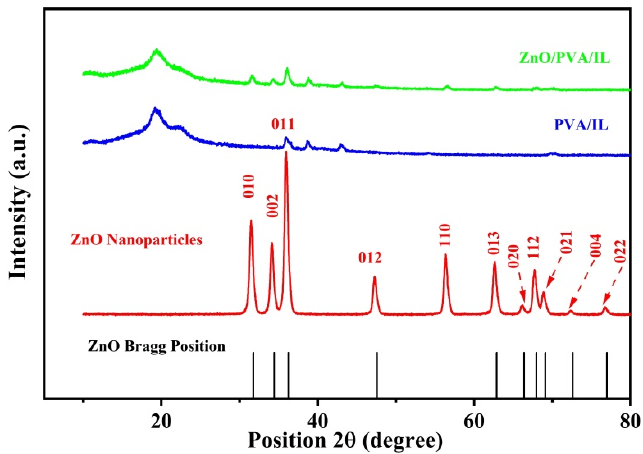
Figure 2. Comparison of XRD pattern for ZnO NPs, PVA/IL membrane and ZnO/PVA/IL composite membrane.